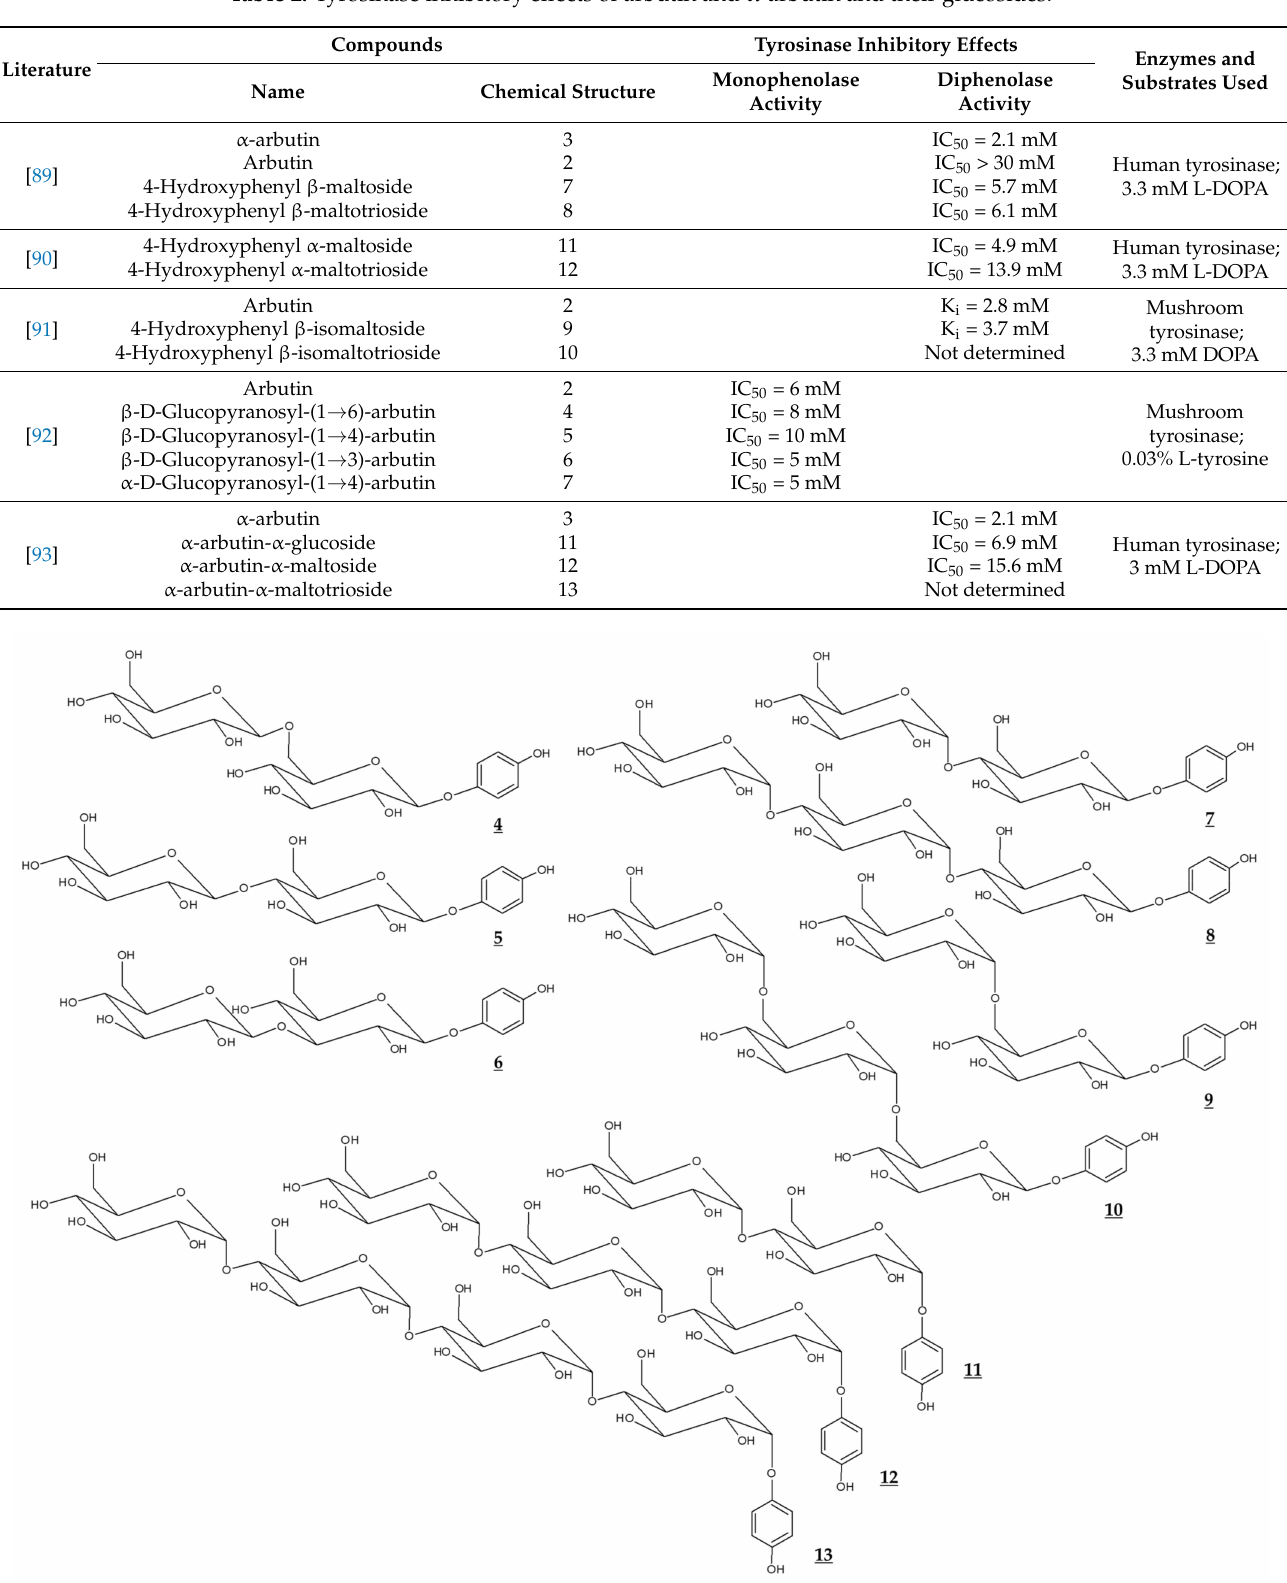
Table 2. Tyrosinase inhibitory effects of arbutin and α -arbutin and their glucosides.